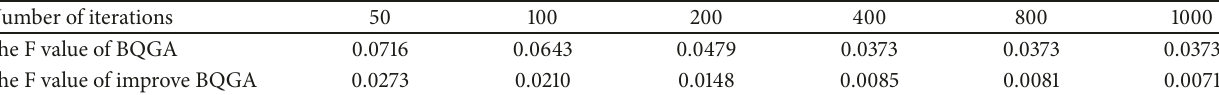
Table 3: Comparison of convergence between basic BQGA and improved